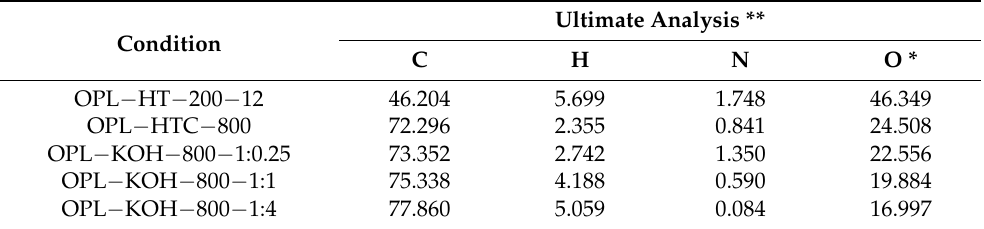
Table 5. Ultimate analysis of OPL via hydrothermal carbonization and KOH activation.